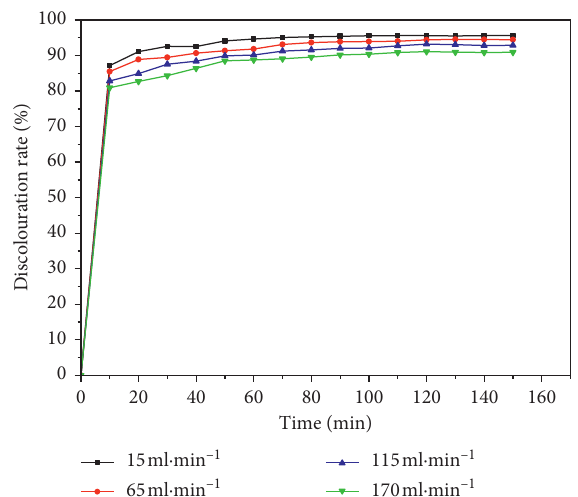
Figure 7: Effect of the withdrawal rate on the discolouration rate.